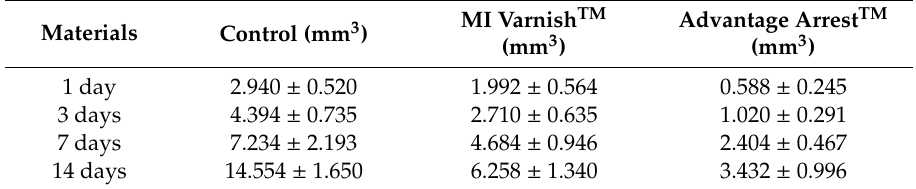
Table 7. Mean ± standard deviation of the demineralized volume change after several treatment durations with the three tested materials.